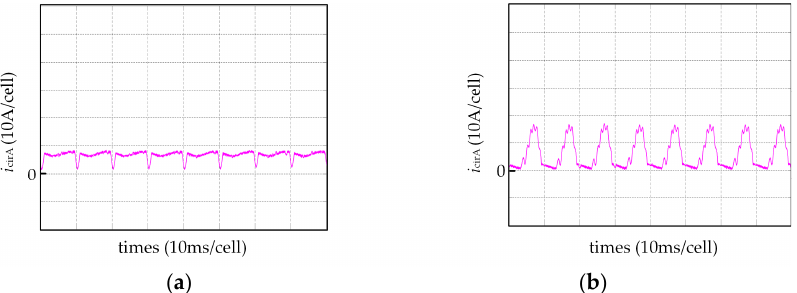
Figure 15. Simulated waveform of the circulating current fluctuation at cos φ = 0.623 ( N = 8). ( a ) The proposed modulation method, ( b ) the conventional modulation method.